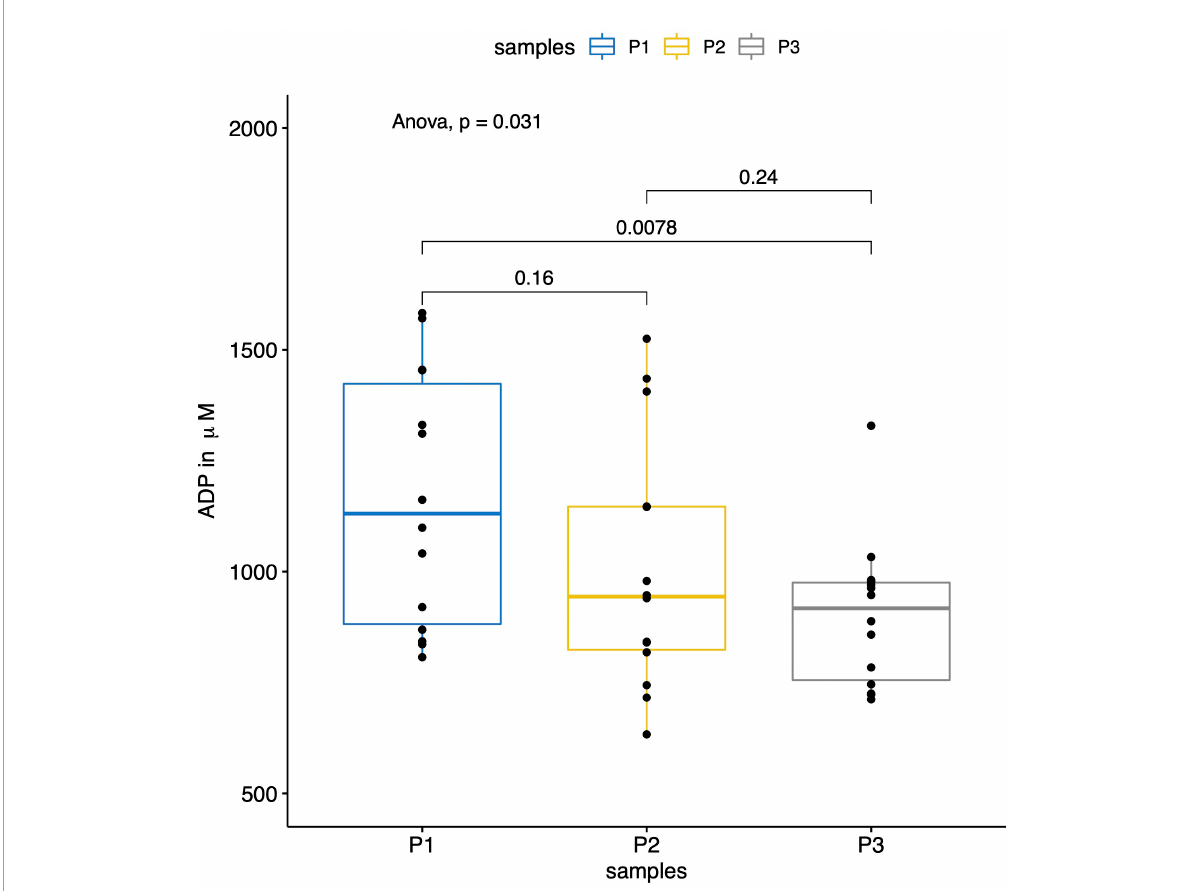
FIGURE4 The boxplot shows the results of the measured ADP levels (in µ M) within the parent vessel (P1) and the aneurysm sac before (P2) and after (P3) flow diversion. The ADP levels were significantly lower within the aneurysm sacs after flow diversion (P3) compared to the ones in the parent vessels (P1) ( p =